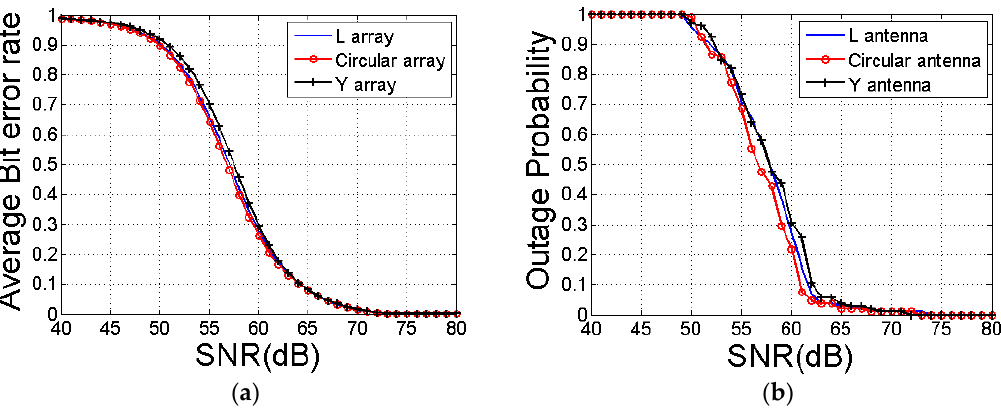
Figure 4. ( a ) Average bit error rate (BER) vs. signal-to-noise ratio (SNR) for three different antenna arrays; ( b ) Outage probability vs. SNR for three different antenna arrays.